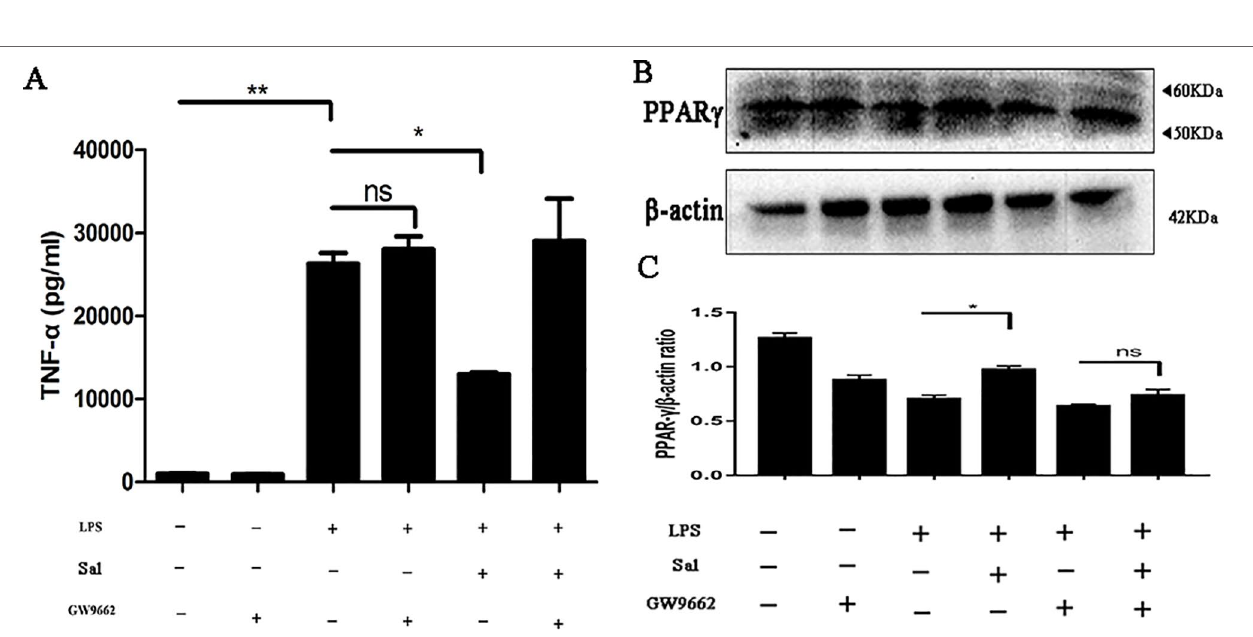
FIgURe 7 | Salidroside exhibited anti-inflammatory activity through regulating peroxisome proliferator-activated receptor (PPARγ) expression. (A) The protein level of TNF-α was measured by enzyme-linked immunosorbent assay. (B) The expression of PPARγ was analyzed by western blot. (C) The relative protein expression of PPARγ was normalized to β-actin. Data were repeated in 3 independent experiments. (*) p < 0.05, (**) p < 0.01, ns, means no significant.